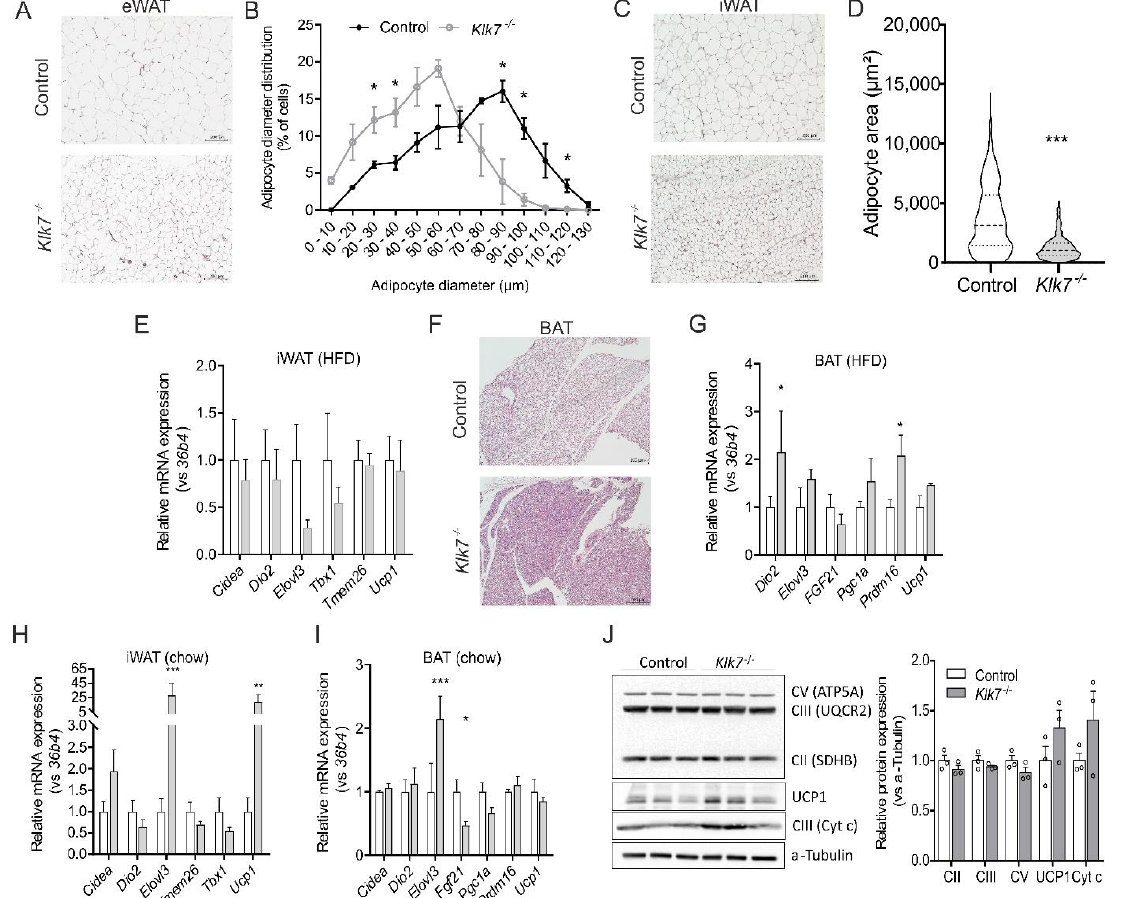
Figure 3. WAT and BAT histology, adipocyte hypertrophy and browning in HFD-fed Klk7 − / − mice. Histological analyses (Hematoxylin and Eosin staining) of epigonadal WAT ( A ) and inguinal WAT ( C ) show highly reduced adipocyte hypertrophy in Klk7 − / − mice with smaller adipocyte diameter (shown for eWAT in ( B )) and adipocyte area (shown for iWAT in ( D )). ( E ) Expression of thermogenic genes in iWAT of HFD-fed Klk7 − / − mice is not changed. ( F ) BAT whitening after HFD feeding in less pronounced in Klk7 − / − mice and genes related to BAT activity ( G ) such as Dio2 and Prdm16 are higher expressed in Klk7 − / − mice compared to controls. ( H , I ) Expression of genes related to thermogenesis and WAT-browning in iWAT and BAT of chow-fed mice shows increased expression of Elovl3 in both AT depots and highly induced Ucp1 expression in iWAT of Klk7 − / − mice. ( J ) Western blot analysis of mitochondrial proteins and UCP1 in differentiated primary brown adipocytes from Klk7 − / − mice. Data are presented as means ± SEM; significance was tested by t -tests ( D ) or multiple t -tests with correction for multiple testing; * p < 0.05, ** p < 0.01, *** p <